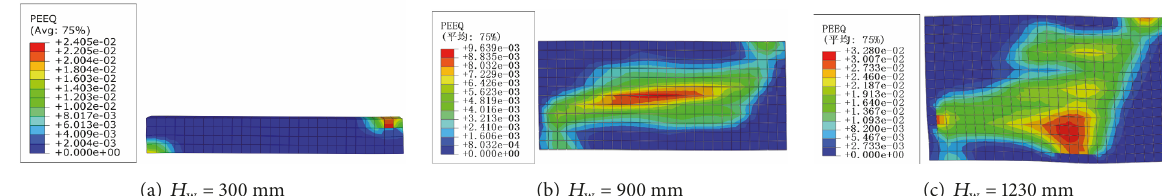
Figure 23: Plastic strain in infill walls ( 𝑓 m =